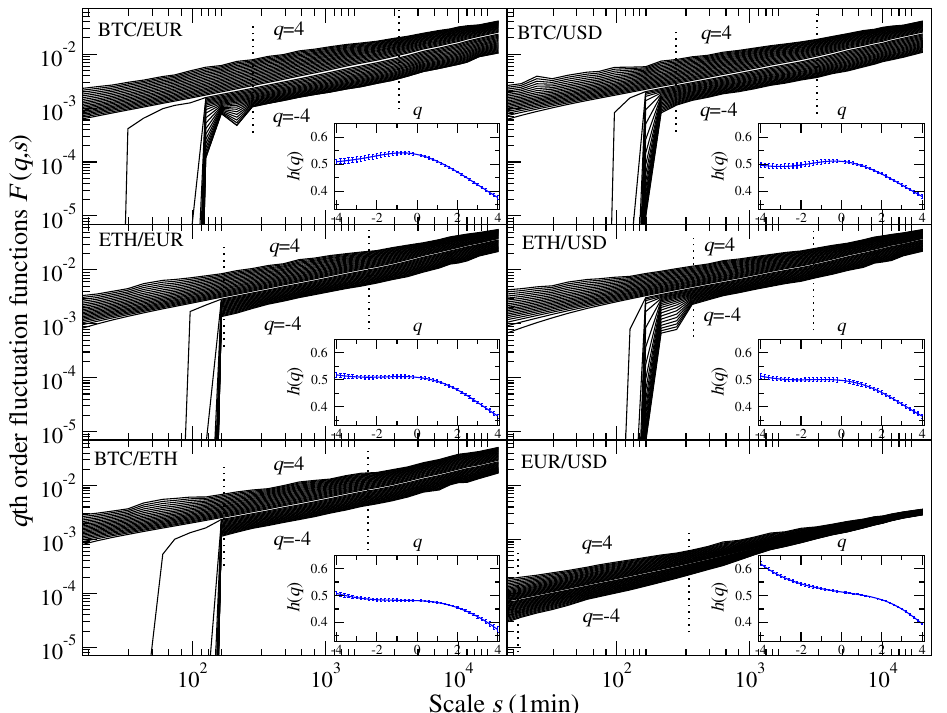
Figure 5. Family of the q th-order fluctuation functions F q ( s ) for different values of q ∈ [ − 4,4 ] in steps of 0.2 (the upper-most one represents q = 4), calculated for the six exchange rates BTC/EUR, BTC/USD, ETH/EUR, ETH/USD, BTC/ETH and EUR/USD. Vertical dotted lines indicate the range of scales used in determining the generalized Hurst exponents h ( q ) . Insets show the corresponding dependence of h ( q ) on q